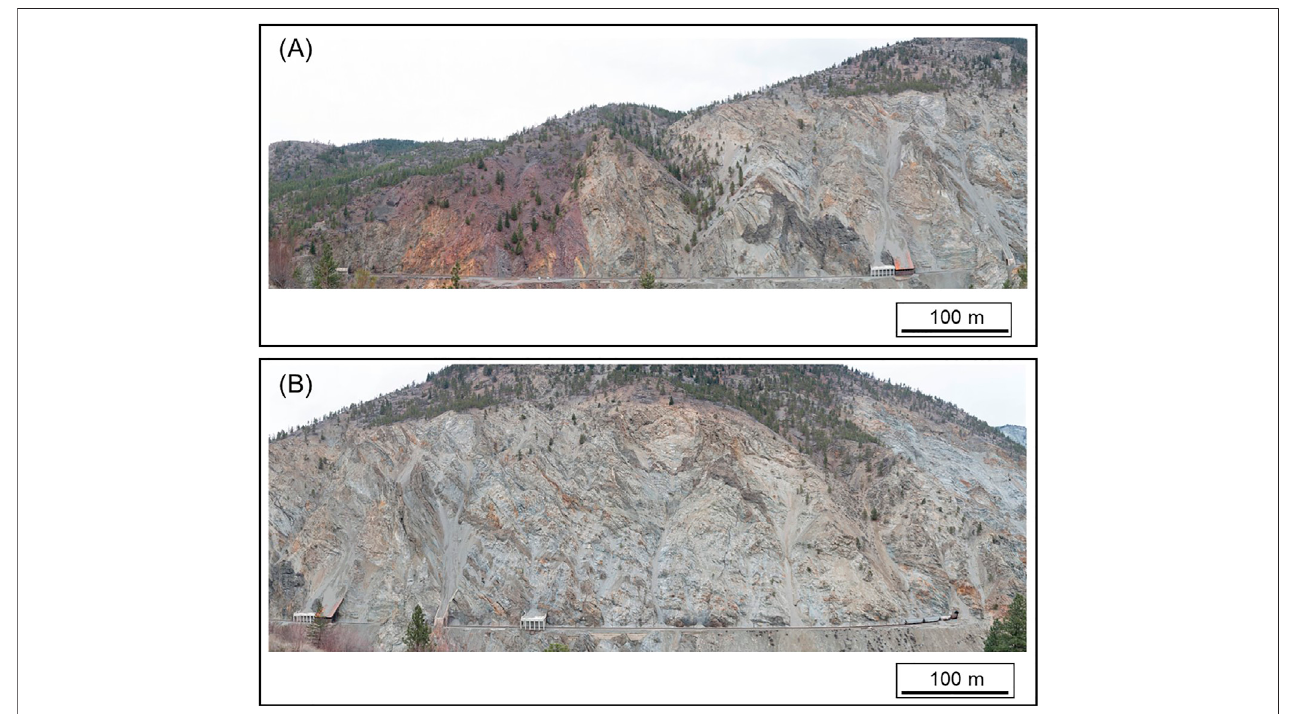
FIGURE 2 | Panoramic photographs of WCW. Note that the scale is not consistent throughout each of the images. (A) This photo shows the Mt. Lytton Plutonic Complexandthefault contact(red-dashedline)withtheLyttonGneiss. (B) Thisphoto showsthecentral portion ofWCW,withtheportal toWCEvisiblenear thebottom right corner of the